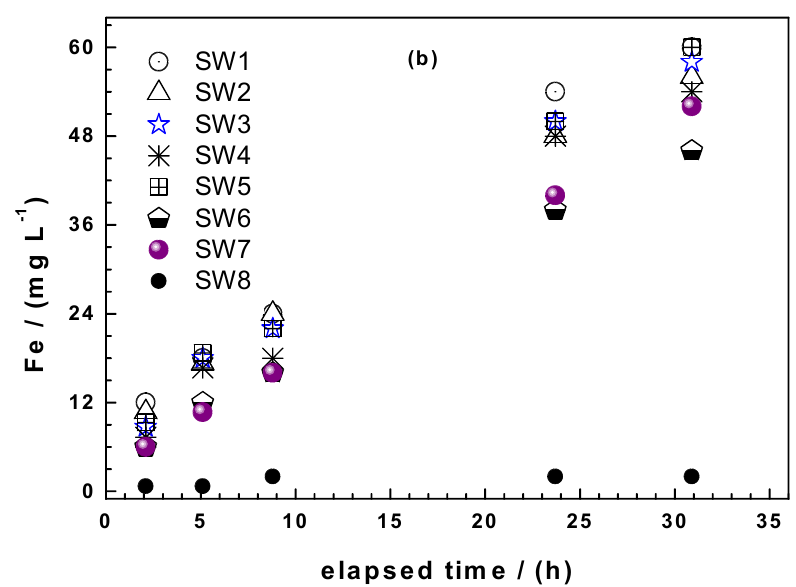
Figure 3. Comparison of the dissolution rate of eight steel wool specimens (SW1 to SW8) in 50 mL of a 2 mM ethylenediaminetetraacetate (EDTA) solution under quiescent conditions for up to 70 h. Experimental conditions: ( a ) m SW = 0.10 g, and ( b ) m SW = 0.01 g. The represented lines are not fitting functions; they just connect the points to ease visualization. Table 3. Corresponding correlation parameters (k EDTA , b, R 2 ) for SW1–SW12 and granular iron. As a rule, the more reactive a material is under given conditions, the higher the k EDTA value. R 2 is a correlation factor. General conditions: 50 mL of 2 mM EDTA solution and 0.01 g Fe 0 . K EDTA , b, and R 2 were calculated using Origin 8.0.